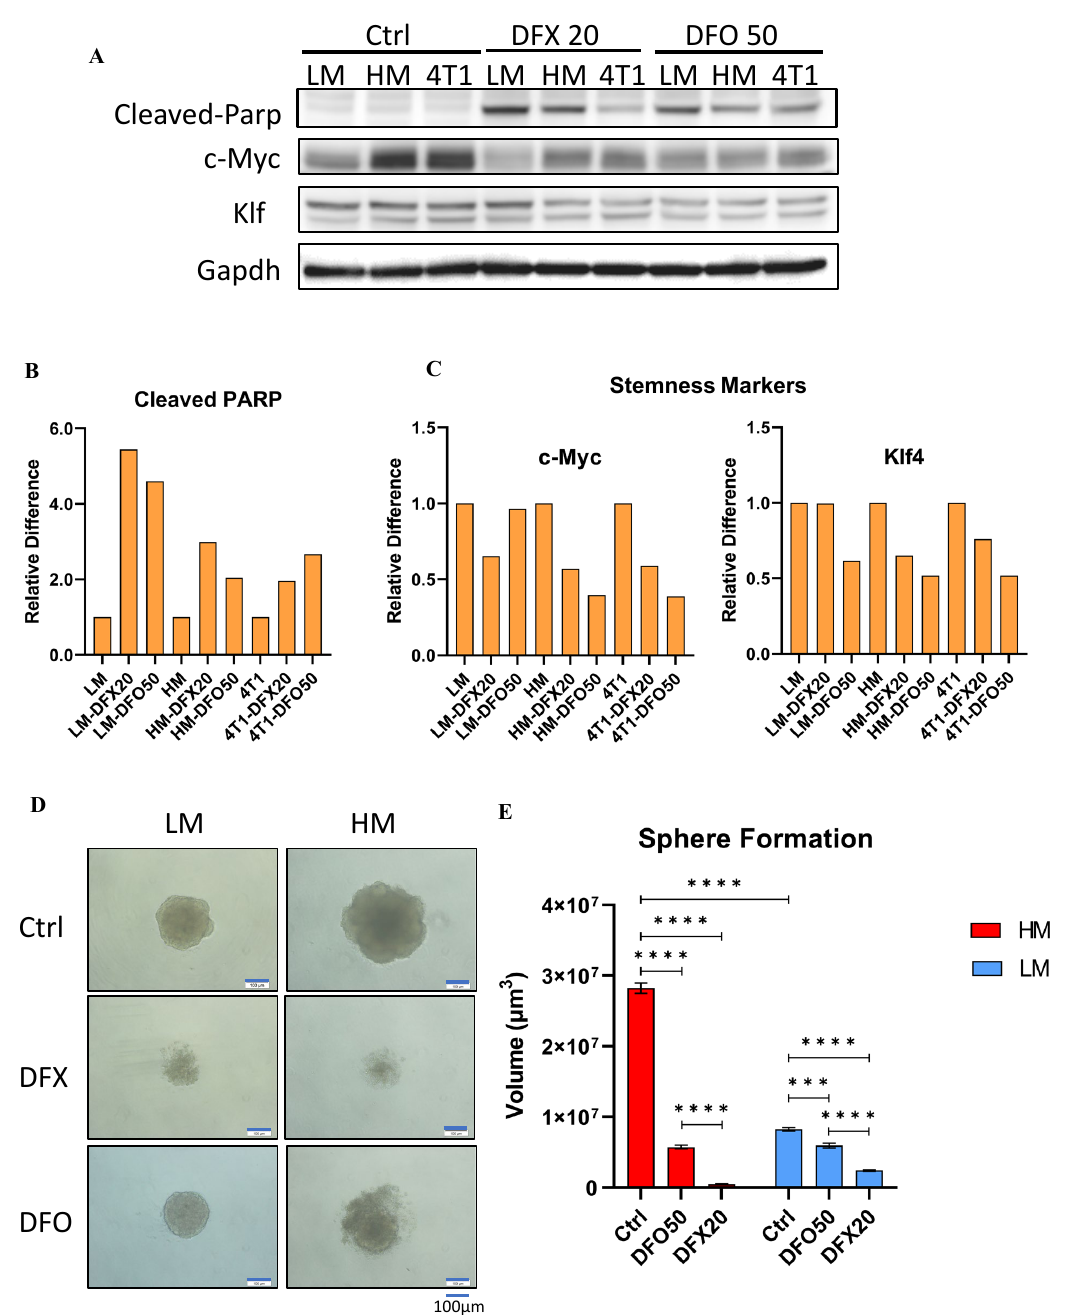
Figure 6. Iron chelators induce apoptosis and inhibit stemness of the 4T1 and its single clones. ( A )